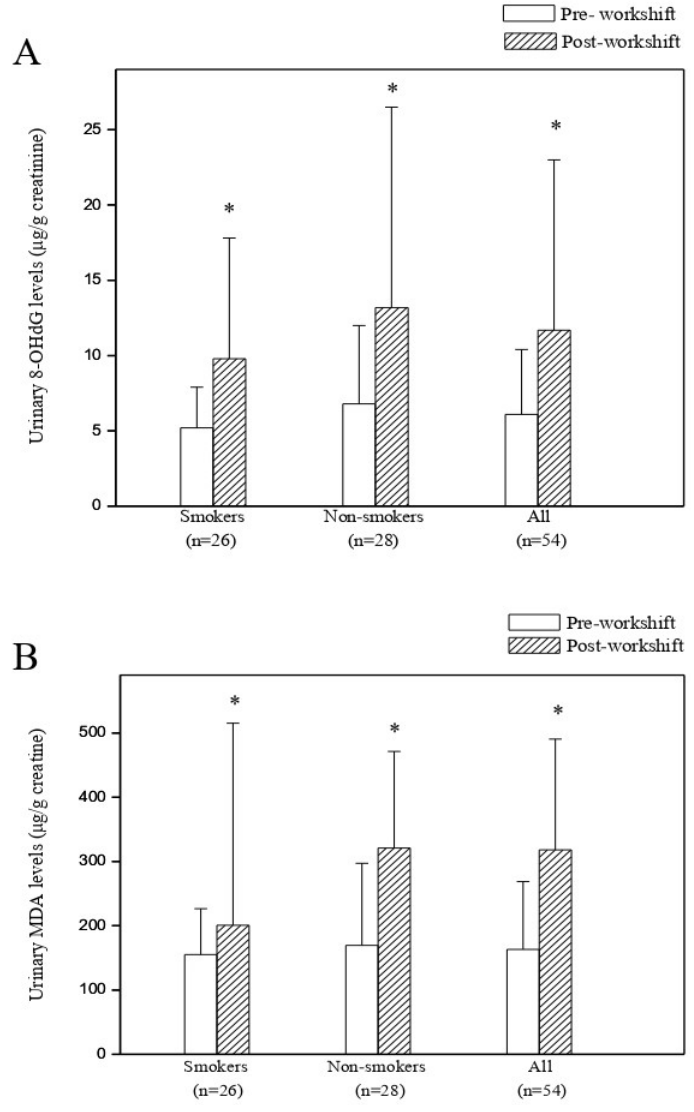
Figure 4. Comparisons of urinary 8-hydroxy-2 ′ -deoxyguanosine (8-OHdG) and malondialdehyde (MDA) levels (mean ± SD ( μ g/g creatinine)) pre-workshift, and post-workshift among 54 cooks in Chinese restaurants. ( A ) Comparison of urinary 8-OHdG levels between pre-workshift and post-workshift, ( B ) Comparison of urinary MDA levels between pre-workshift and post-workshift. Statistical significance of paired t- test for comparing pre- and post-workshift levels after log-transformation at *, p < 0.05.